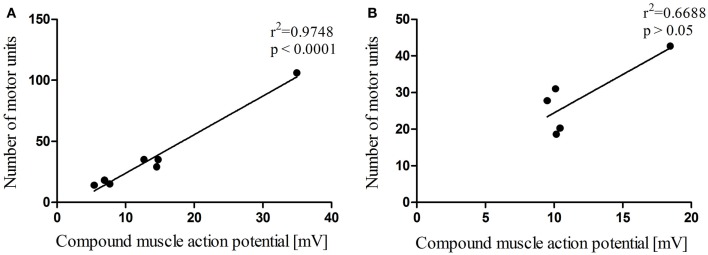
Correlation analysis between the number of motor units and the CMAP. The decrease in the number of motor units correlates to the reduction of the CMAP in the heterogeneous group (A). No significant correlation was found in the homogeneous group (B). Values are mean ± SEM; *P < 0.05.